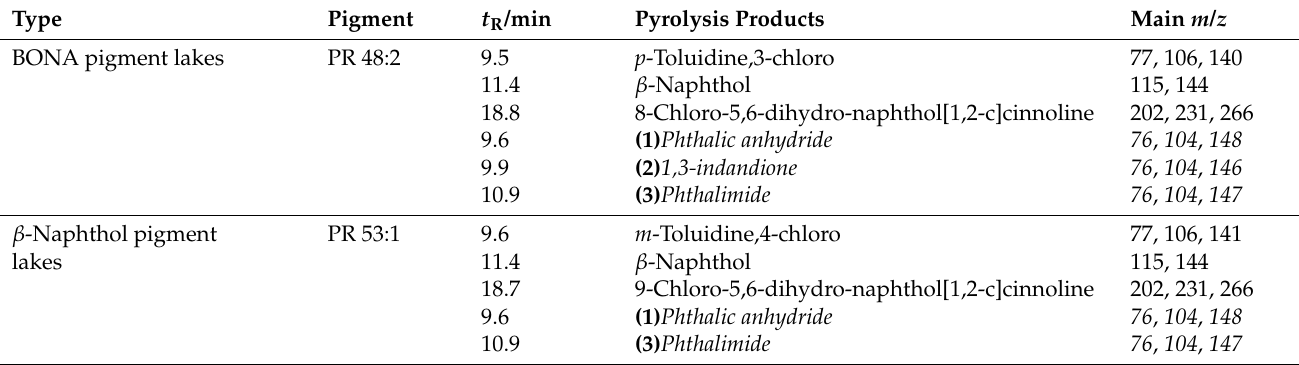
Table 1. Main pyrolysis products of the red azo-pigments PR 48:2 and PR 53:1 [77]. The degradation products are numbered and marked in italic